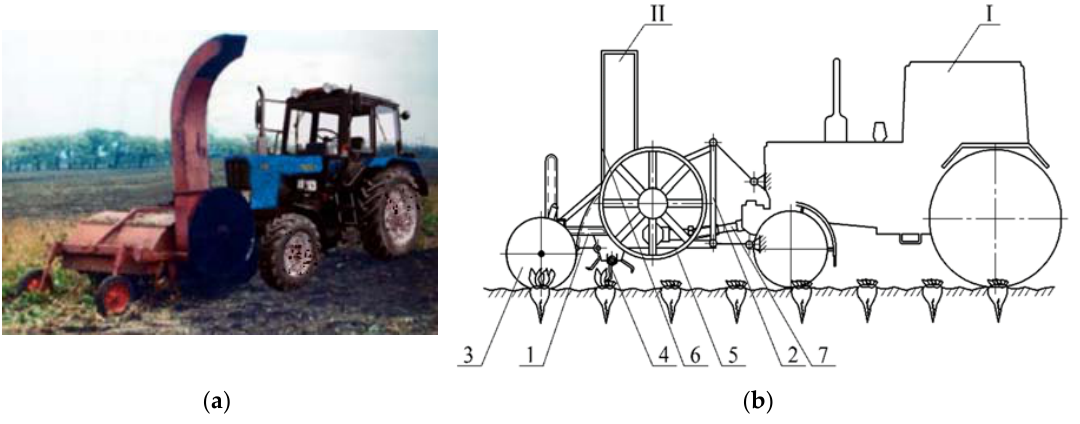
Figure 1. Tractor – harvester aggregate: ( a ) photo taken during experimental field test phase, ( b ) Figure schematic representation: I—Wheeled, row ‐ crop integrated tractor; II—Front ‐ mounted beet topper machine: 1—frame, 2—point hitch, 3—pneumatic feeler wheel, 4—rotary beet top cutting device, 5—